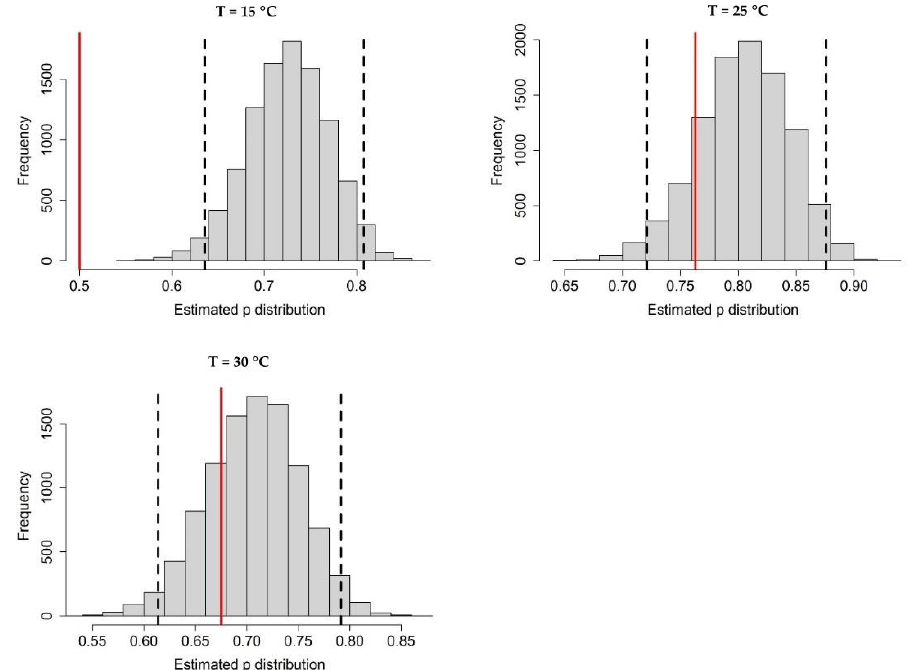
Figure A4. Estimated posterior distributions of P L1-A (T), the survival rate from L1 to A at 15, 25, and 30 °C. Dashed black lines represent the 2.5 and 97.5 quantiles. Solid red lines represent the average value for subtropical Ae. albopictus .